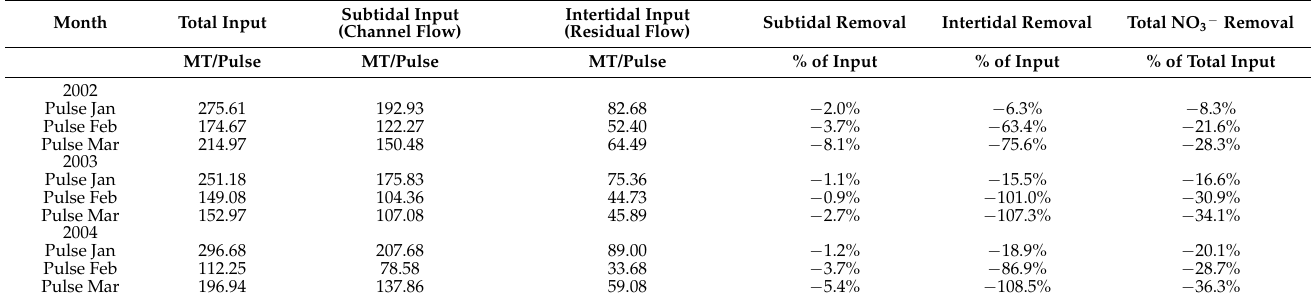
Figure 11. ( a ) Estimates of nitrate loading to upper Breton Sound based on routing along channels and bays (black bar) and as sheet-flow over intertidal wetlands (gray bar) during nine flood-pulse events of the Caernarvon freshwater diversion based on discharge rates and NO 3 − concentrations measured near diversion outlet in January, February and March of 2002, 2003, and 2004. The total NO 3 − load was distributed 70% to subtidal and 30% to intertidal [13] . ( b ) Estimates of NO 3 − removal during each flood-pulse experiment based on benthic uptake rates and area of contact with diverted water with subtidal and intertidal habitats using thresholds of field conditions explain in this study. ( c ) Estimates for input (gray bar) and removal (black bar) are the subtidal and intertidal habitats. All units of input and removal are metric tons per pulse event (MT/pulse). Table 6. Estimates of nitrate loading to upper Breton Sound from nine river-pulse experiments of the Caernarvon diversion based on discharge rates and NO 3 − concentrations measured near diversion outlet during each pulse. Estimates of NO 3 − removal during each pulse experiment is based on uptake rates and area of contact with diverted water using assumptions explain in this study. Percent of the NO 3 − input that is removed by subtidal, intertidal, and total outfall area are provided in percent of input NO 3 − estimated for each pulse. All units of input and removal are metric tons per pulse event